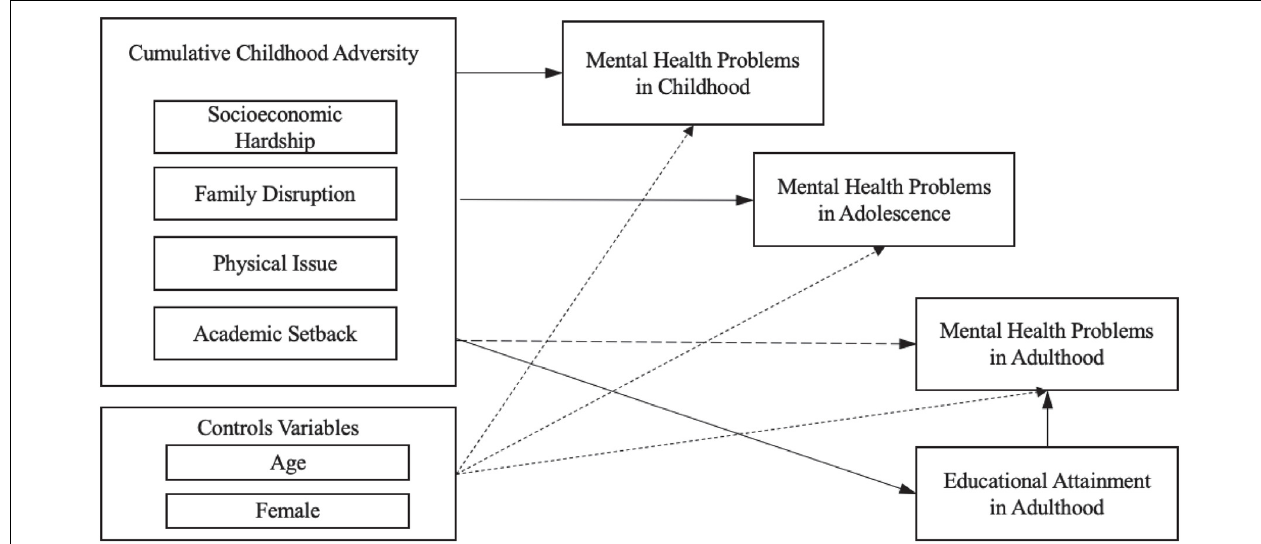
FIGURE 1 | Illustration of the life-course theoretical